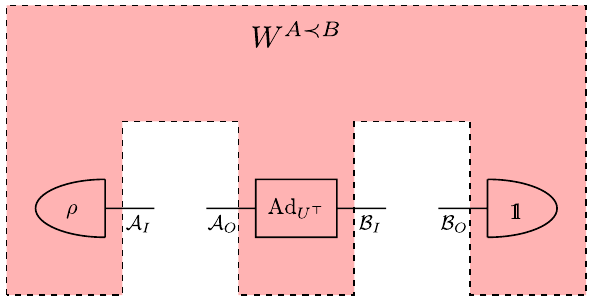
Figure 5. A schematic representation of process matrix W A ≺ B given by Eq.